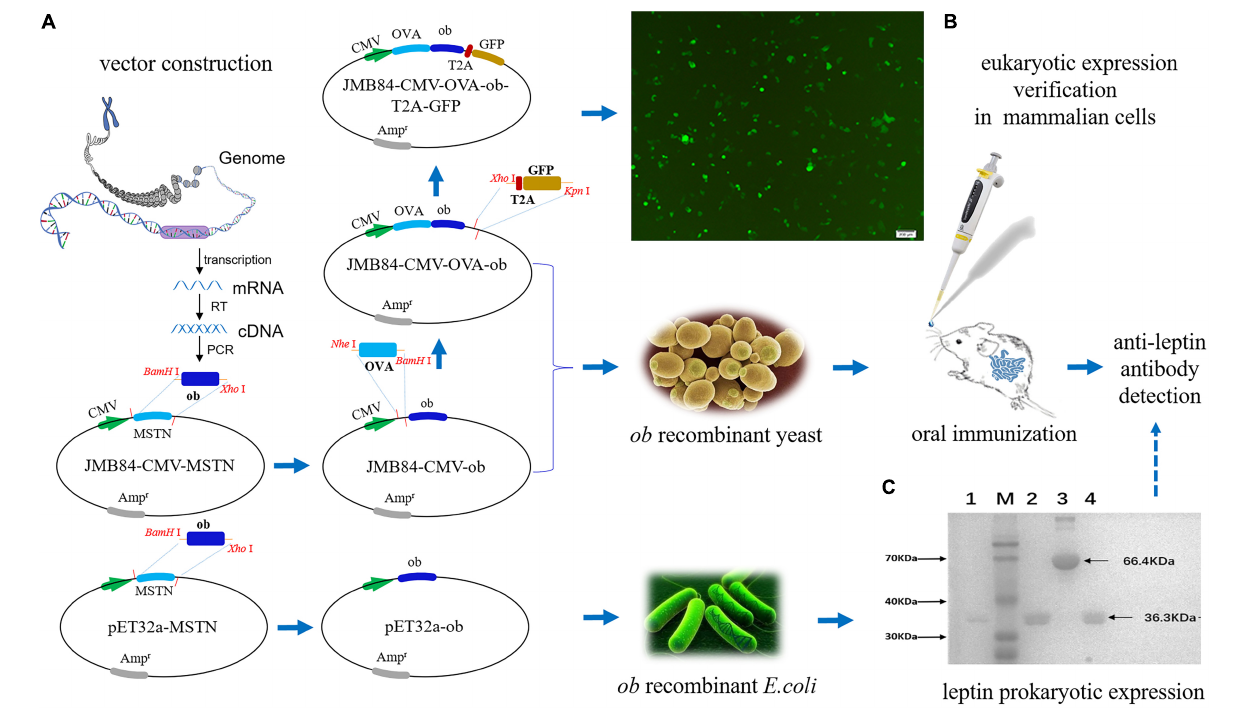
FIGURE 1 | Schematic diagram of the experiment design and vector verification. (A) Flow chart for the construction of the plasmid vectors. (B) Fluorescence observation of the 293T cells transfected with the JMB84-CMV-OVA-ob-T2A-GFP vector. The GFP expression suggested the recombinant CMV-OVA- ob cassette, as a DNA vaccine, could be expressed successfully in mammalian cells. (C) SDS-PAGE electrophoresis result of the purified leptin protein. Line 1, 2, and 4: purified leptin proteins expressed by different E. coli Rosetta (DE3) transformants. Line 3, the bull serum albumin (BSA) control. M: Blue Plus II protein